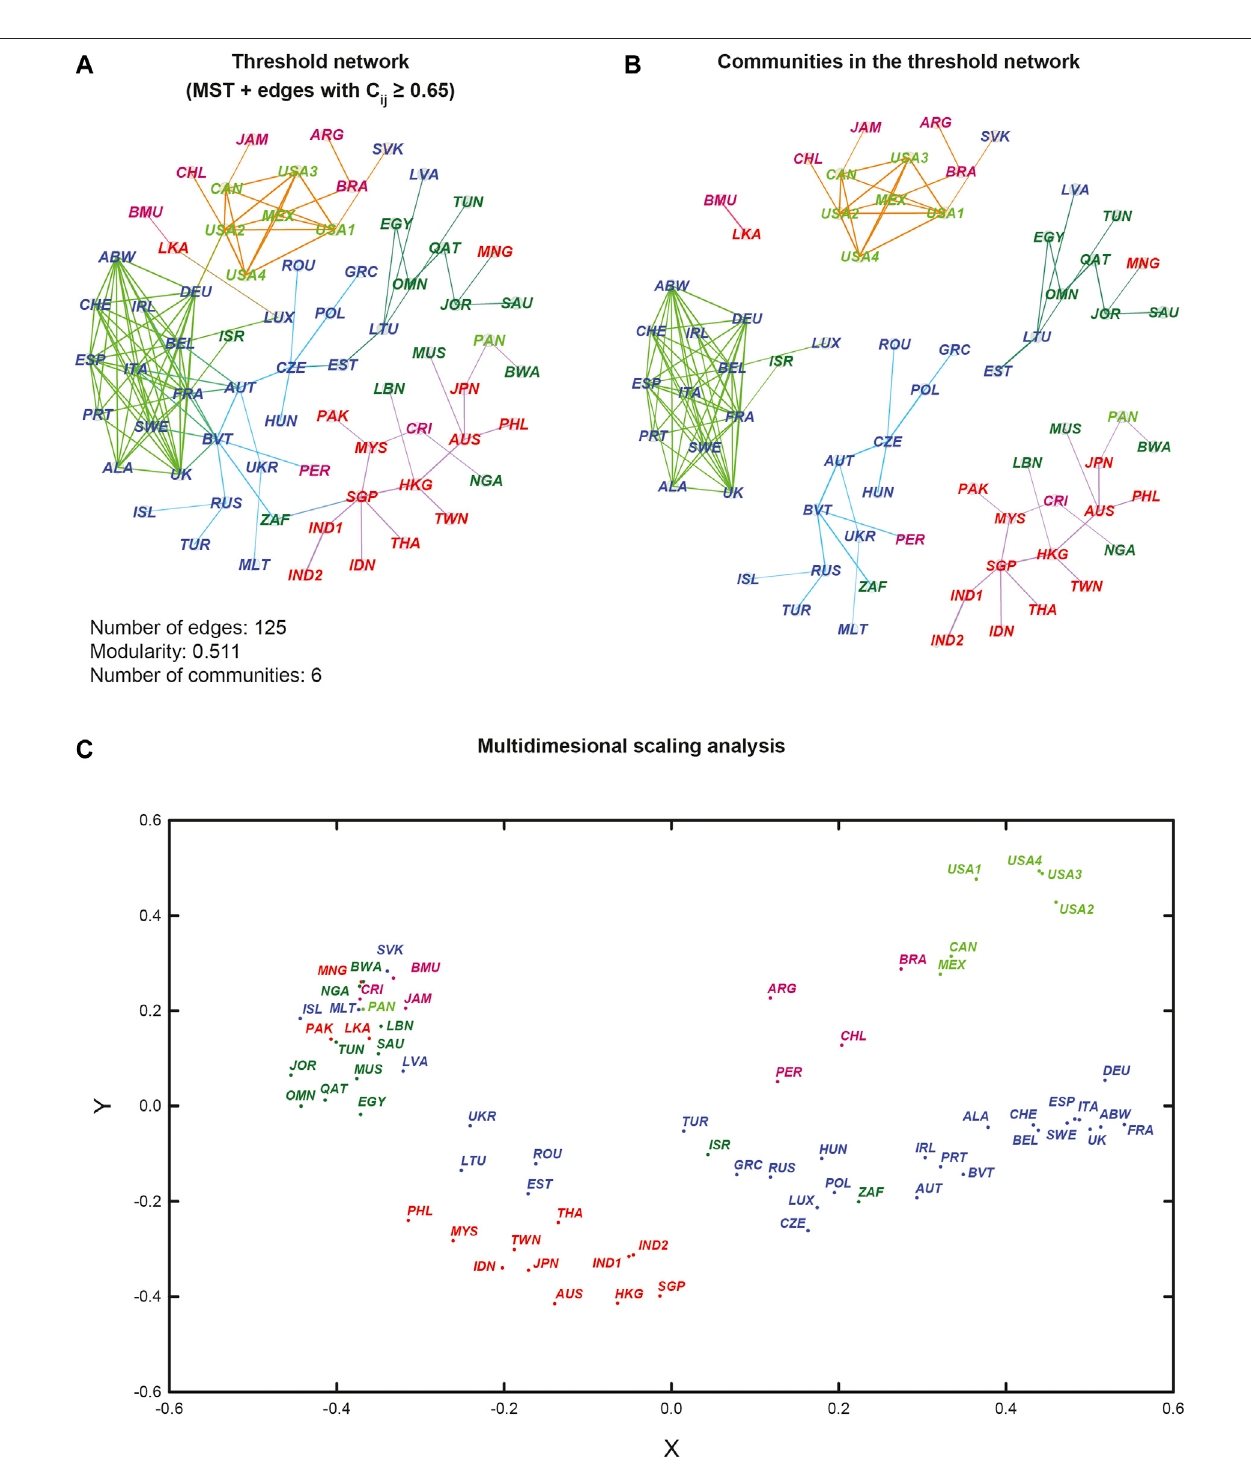
FIGURE 4 | The average correlation structure between 69 market indices over the 14-year period is visualized based on the correlation matrix C T for the complete period of T (cid:1) 3513 days between 2000 to 2014. (a) Visualization of the overall threshold network S T corresponding to C T obtained by combining MST plus edges with correlation ≥ 0.65. The node colours are based on geographical regions of the market indices and edge colours are based on communities obtained from Louvain method. (b) Visualization of the communities in the overall threshold network S T after removing the inter-module edges. It is evident that the market indices form communities in this network based on their geographical proximity. (c) Multidimensional scaling (MDS) map in 2-dimensions of the 69 market indices. In this fi gure, the indicesarelabelled indifferentcoloursbasedontheirgeographicalregionand country,respectively.ThefourUSAmarketindices,NASDAQ,NYSE,RUSSELL1000and SPX, are labelled as USA1, USA2, USA3 and USA4, respectively, while the two Indian indices, NIFTY and SENSEX30, are labelled as IND1 and IND2, respectively.